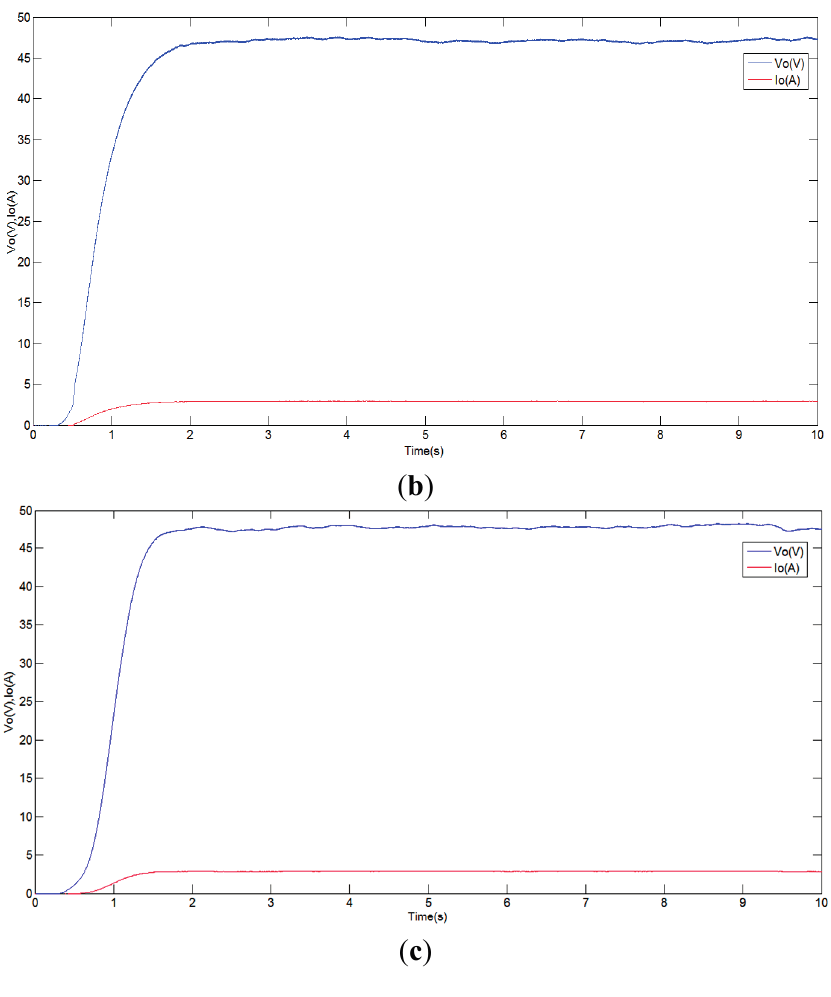
Figure 12. ( a )ESMS output voltage (Vo) and current (Io); ( b ) SMS output voltage (Vo) and current (Io); ( c ) P&O control output voltage (Vo) and current (Io).